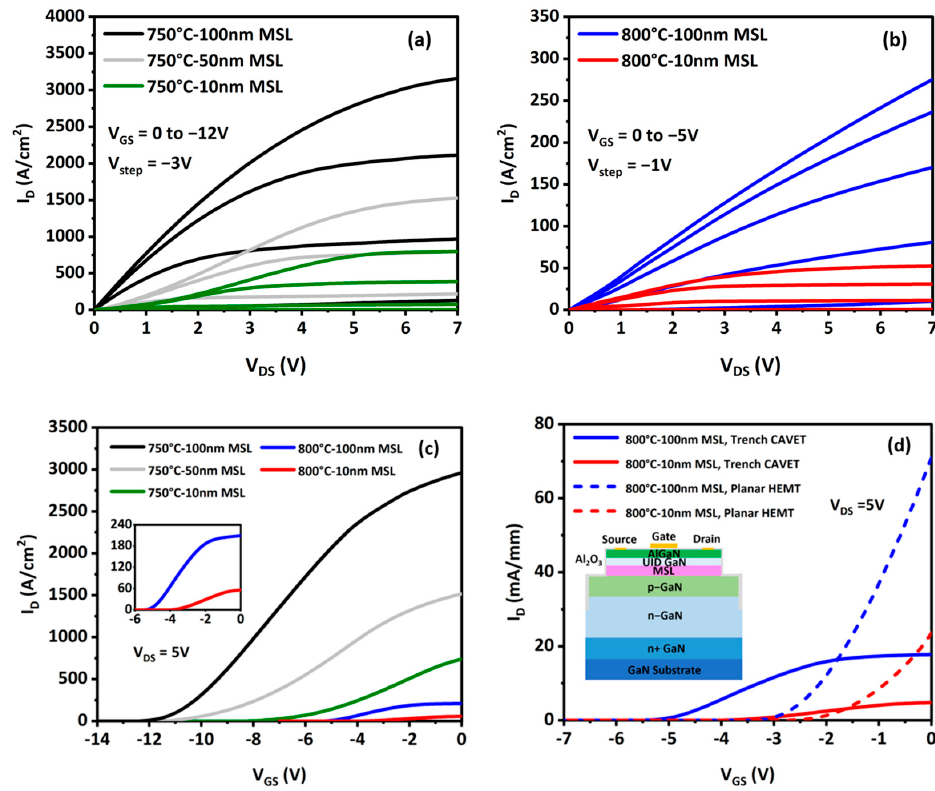
Figure 4. I D -V DS output characteristics of the fabricated trench CAVETs with varying MSL thicknesses grown at ( a ) 750 ◦ C and ( b ) 800 ◦ C. ( c ) I D -V GS transfer characteristics of the five fabricated trench CAVETs with different growth thicknesses and temperatures. ( d ) I D -V GS transfer characteristics comparison between the trench CAVETs and planar HEMTs with MSL grown at 800 ◦ C (the schematic of planar HEMT is shown in the inset).